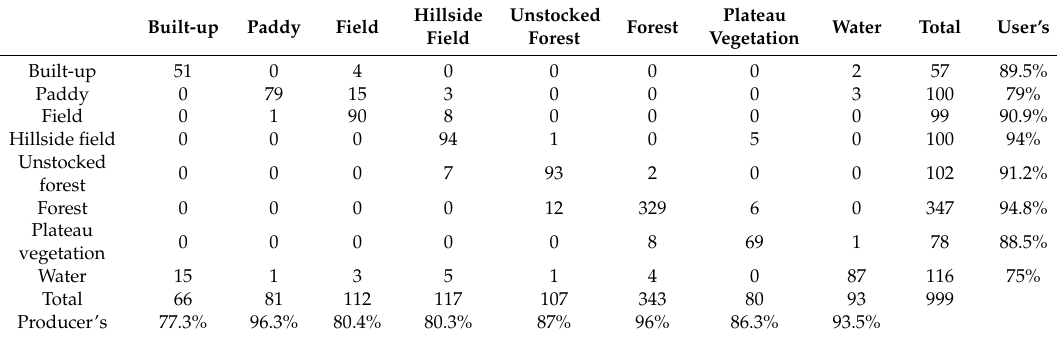
Table 2. Confusion matrix for land cover classification of North